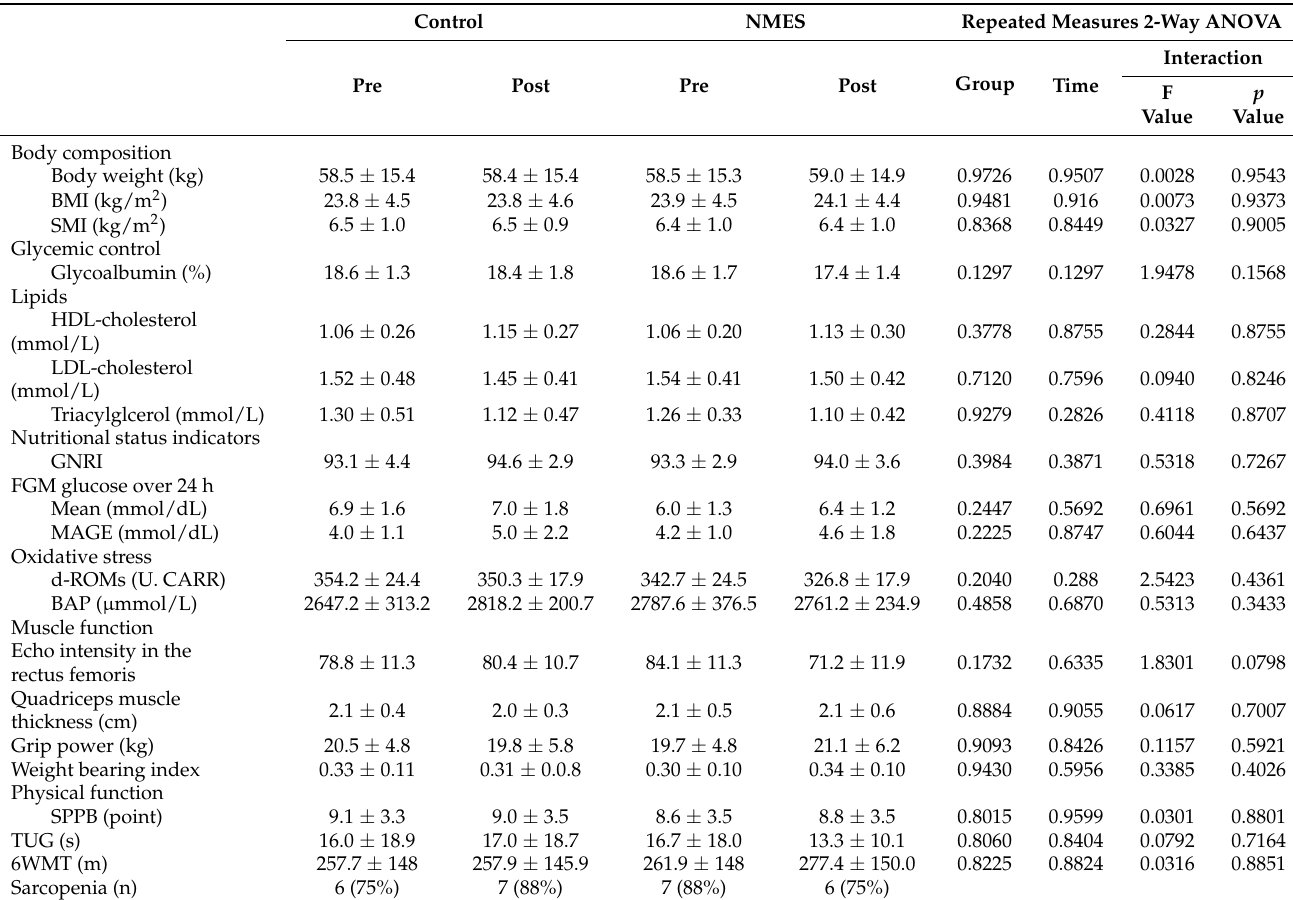
Table 2. Clinical variables recorded in stage 2 of the